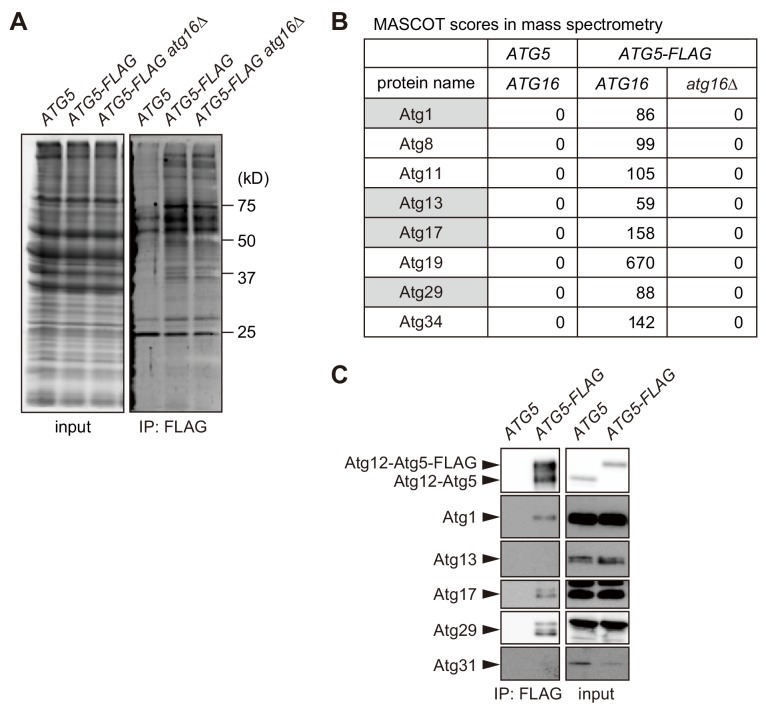
Proteomic analysis to identify proteins bound to the Atg16 complex.(A) Yeast cells expressing Atg5-FLAG were converted to spheroplasts, treated with rapamycin for 2 hr, solubilized with 1% DDM, and subjected to immunoprecipitation using anti-FLAG antibody. Immunoprecipitates were analyzed by SDS-PAGE, followed by SYPRO Ruby staining. (B) Immunoprecipitates analyzed in (A) were subjected to mass spectrometry, and the MASCOT scores for Atg proteins identified are shown. Proteins with gray background are components of the Atg1 complex. (C) Immunoprecipitates of Atg5-FLAG were prepared as described in (A), and analyzed by immunoblotting using antibodies against Atg12, Atg1, Atg13, Atg17, Atg29 and Atg31.